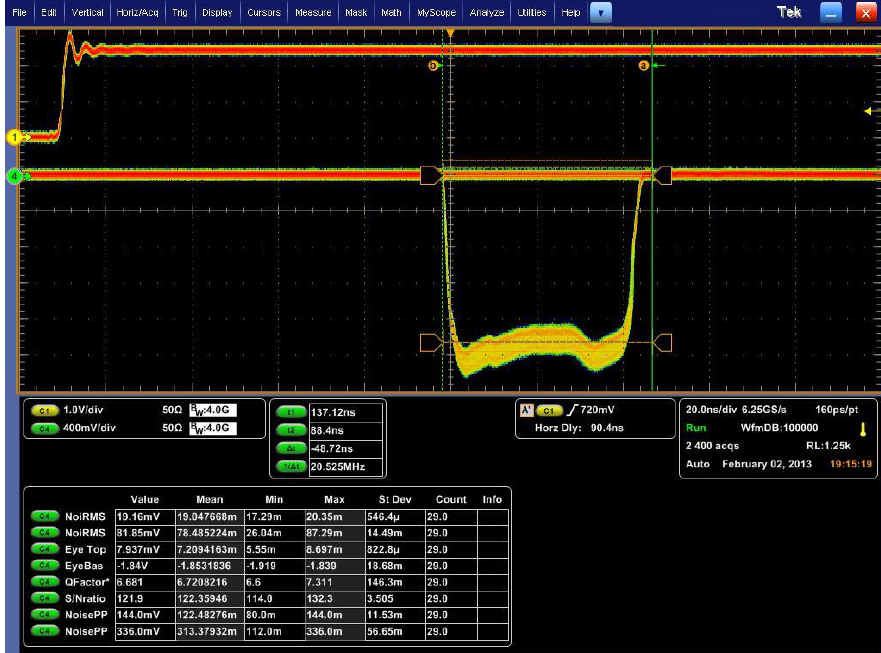
Figure 6. Sample oscillogram obtained during bit error rate (BER) measurements.